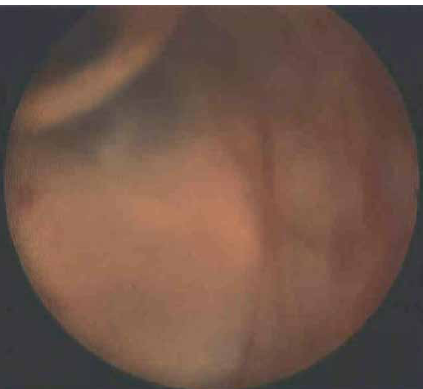
Figure 5: Ureteroscopy showing a blind-ending right ureter compressed by a mass with purple discolouration at the level of the pelvic brim.